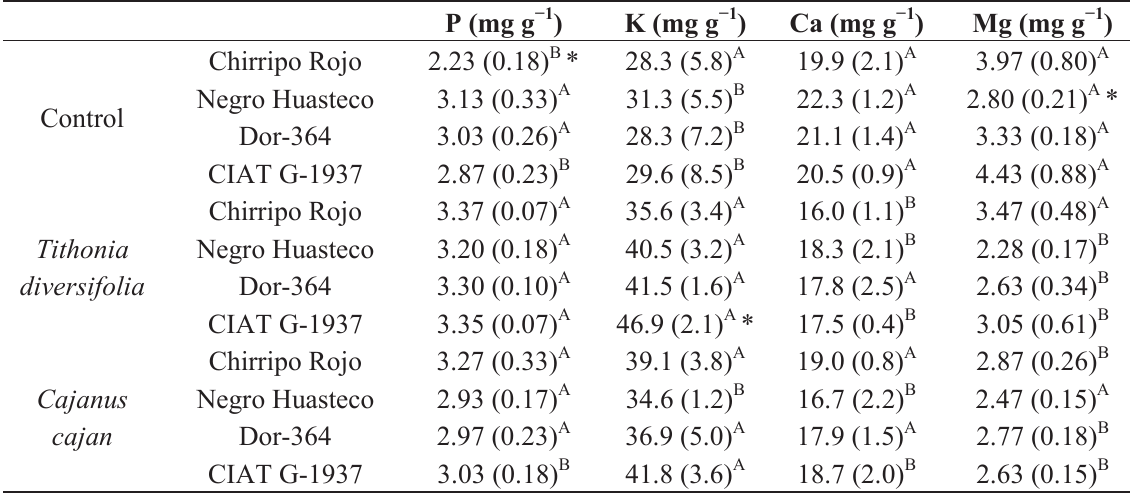
Values followed by different upper case letters indicate significant differences at p < 0.05 in the comparison of mulch treatments within the same bean genotype. Values followed by *, comparing differences between bean genotypes and within mulch treatments, are significantly different at p <